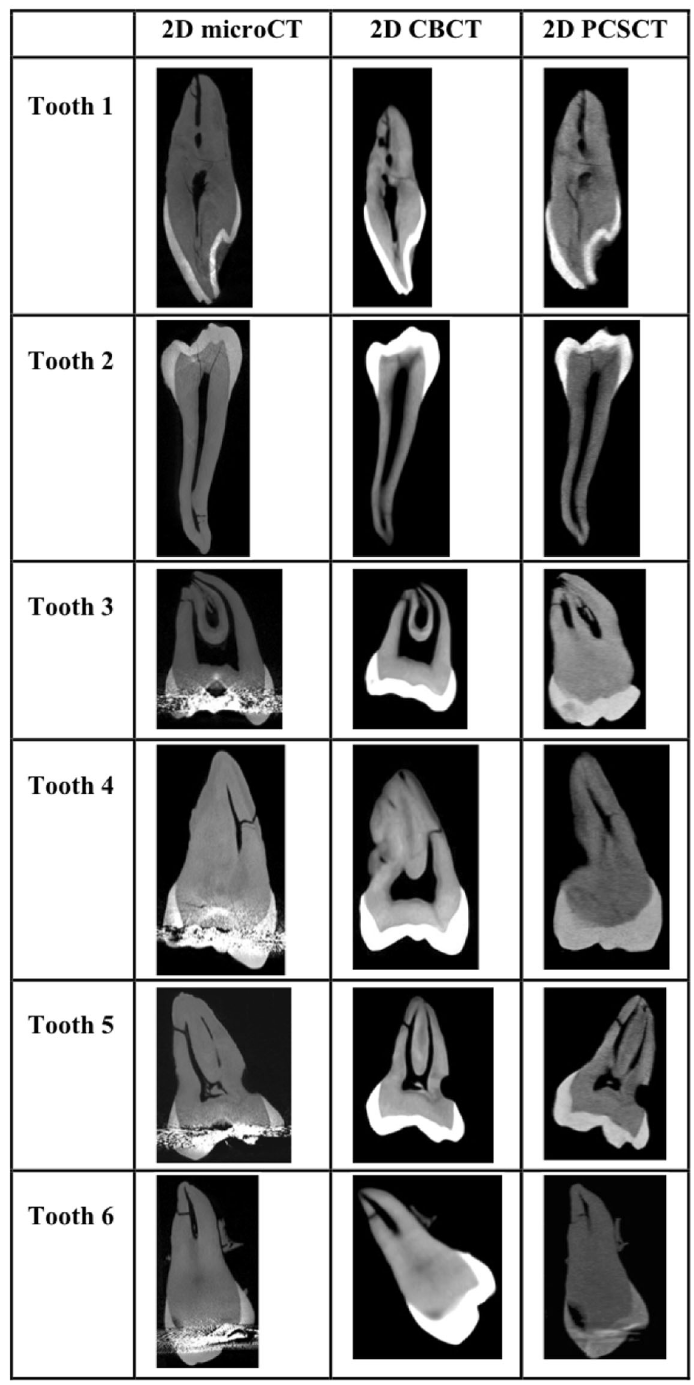
Fig. 1 Representative 2D microCT, CBCT, and PCSCT images, for each tooth. The same AC is shown for each